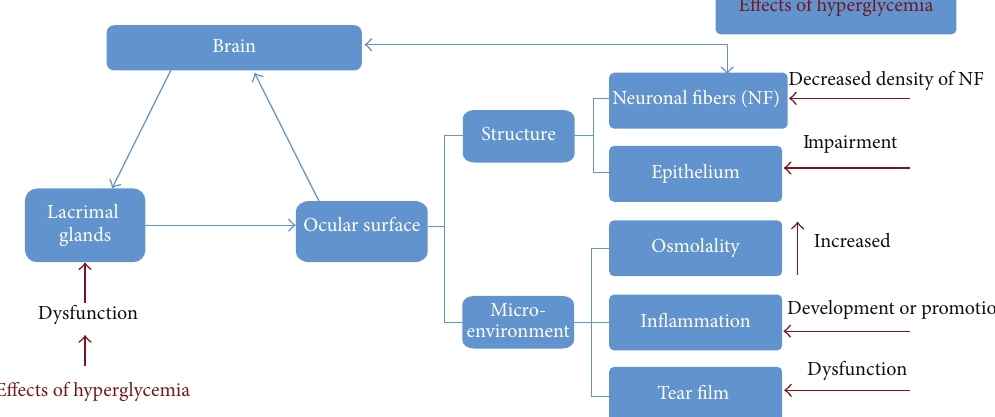
Figure 1: Lacrimal function unit (LFU) is composed of the “cornea, conjunctiva, lacrimal gland, meibomian gland, lids, and the sensory and motor nerves that connect them,” which protect and maintain the tear film and normal function of the ocular surface. LFU plays a regulatory role in tear secretion and tear film formation to maintain the normal physiology of the ocular surface; damage to any component of LFU leads to tear-deficient or evaporative diabetes mellitus associated dry eye